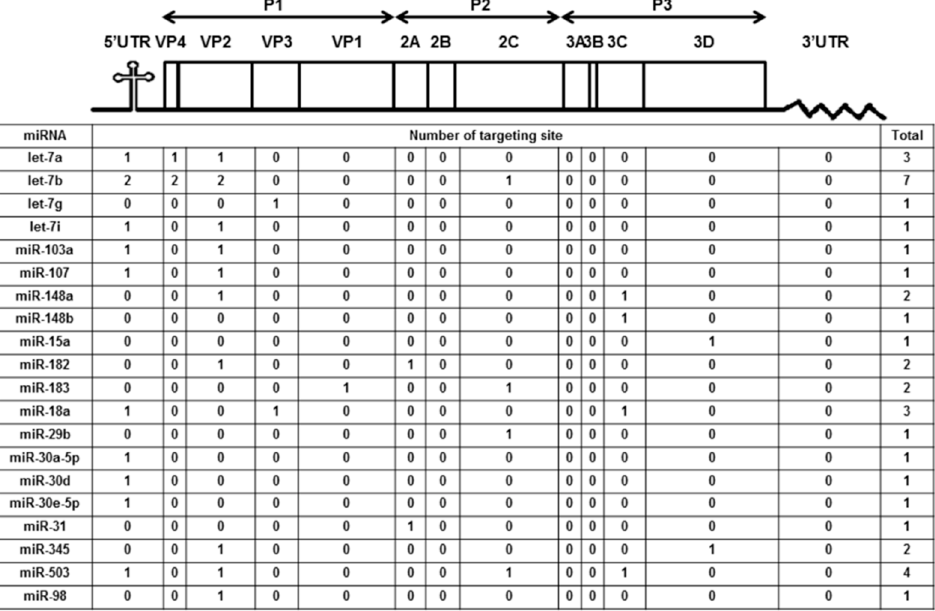
Figure 1. Honeysuckle ingestion induced twenty miRNAs both in mice and humans that are able to recognize the EV71 genome at various regions and the corresponding proteins. Four hundred 10-week-old C57/B6 mice and 17 healthy human volunteers ingested honeysuckle aqueous extract as described in the Methods. The upregulated endogenous miRNAs in the blood of the mice and humans were determined [2]. The overlapped miRNAs between mice and humans predicted to be able to target EV71 at multiple regions by “miranda v3.3a” are illustrated. The miRNA sequences were from “miRBase 22 release” and the viral sequences were from the Nucleotide database of NCBI (Accession No. AF304458).